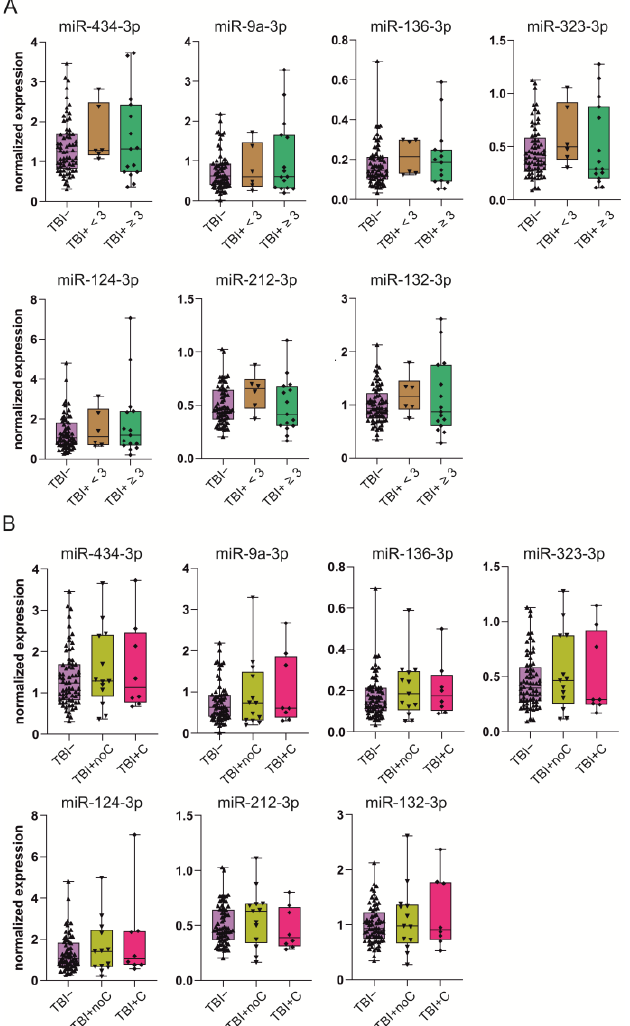
Figure 6. Normalized plasma miRNA levels on D2 and severity of epilepsy. ( A ) Rats with frequent (i.e., ≥3 late seizures per month) vs. less frequent seizures (<3 seizures per month). Box and whisker plots (whiskers: minimum and maximum; box: interquartile range; line: median) show that plasma miRNA levels on D2 in TBI+ animals with frequent (15/21) or less frequent late seizures (6/21) were comparable (Mann–Whitney U test, p > 0.05). In addition, the average miRNA levels were comparable when the TBI+ rats with frequent seizures were compared with TBI − animals or with all remaining TBI rats (TBI+ > 3 seizures vs. TBI − and TBI+ < 3 seizures; p > 0.05). ( B ) Rats with or without seizure clusters (i.e., ≥ 3 seizures within 24 h). Box and whisker plots summarize the levels of miRNAs in rats with epilepsy (TBI+) with seizure clusters (TBI+ C, 8/21) or without seizure clusters (TBI+ noC, 13/21). Plasma miRNAs on D2 did not differ between the rats with or without seizure clusters (Mann–Whitney U test, p > 0.05 for all miRNAs). In addition, plasma miRNA levels were comparable when the TBI+ rats with seizure clusters (severe epilepsy) were compared with TBI − rats or with all remaining TBI rats (TBI+ C vs. TBI − and TBI+ noC; TBI − , n = 69, p > 0.05). Abbreviations: TBI, traumatic brain injury; TBI − , TBI rats without